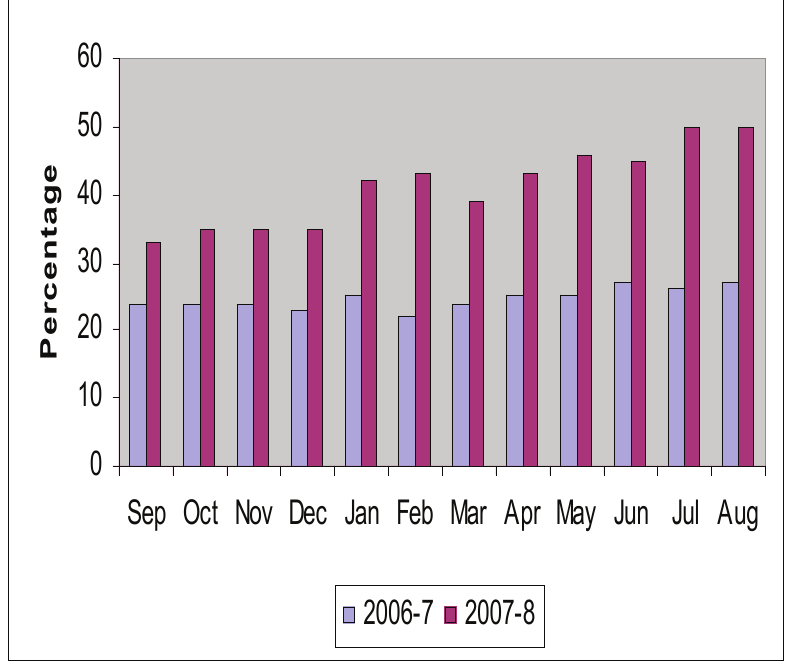
Figure 3: Comparison of 2006-7 & 2007-8 pass rates (National)